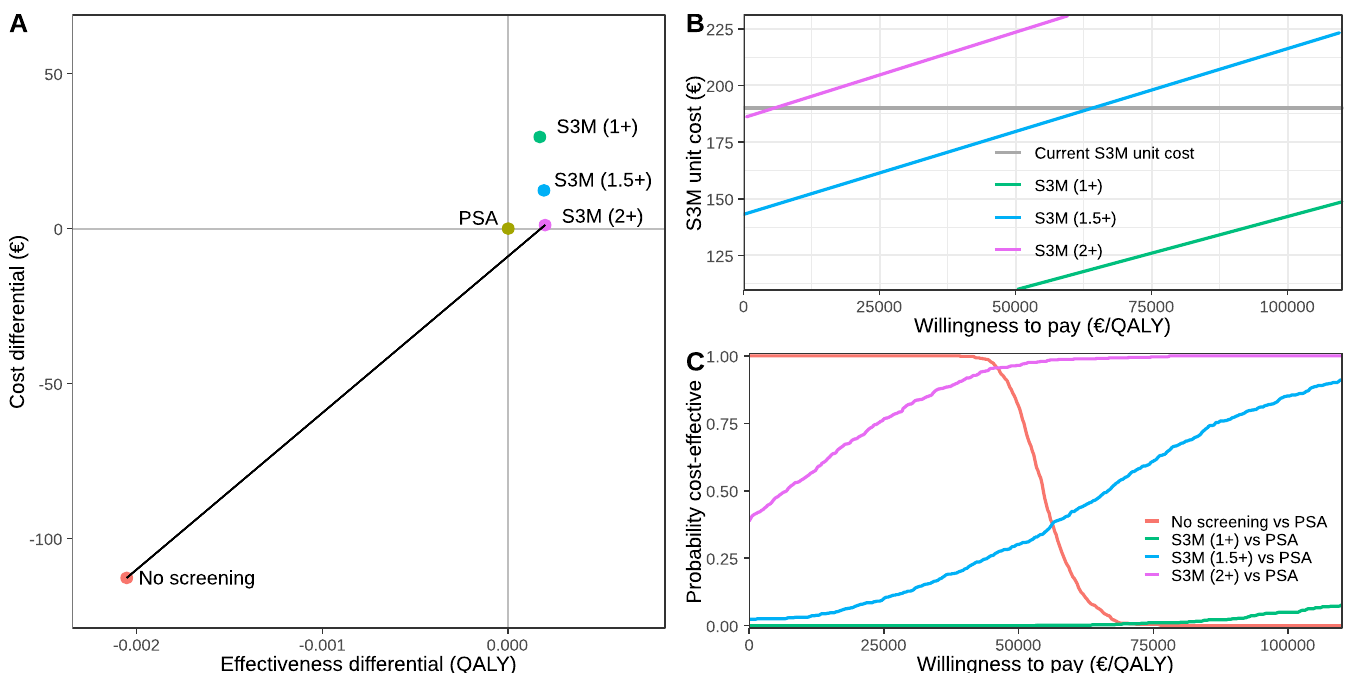
Fig 3. Panel (A) shows the cost-effectiveness plane comparing no screening, PSA screening and S3M screening with reflex thresholds at 1 ng/mL, 1.5 ng/mL and 2 ng/ mL. The effectiveness and costs are incremental relative to PSA screening and discounted at 3% per annum. Panel (B) shows the ICER ( € /QALY) for S3M as a reflex for PSA above 1, 1.5 and 2 ng/mL as functions of the unit cost of S3M. The cost-effectiveness ratios are incremental to PSA screening alone and are discounted at 3% per annum. The current S3M unit cost, of € 196, is shown as the grey line. Finally, Panel (C) shows the probability that an intervention is more cost-effective than PSA screening under parameter uncertainty for a specific willingness to pay